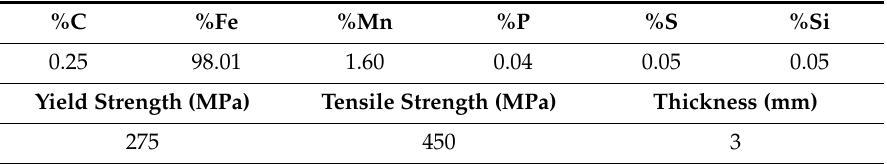
Table 1. Chemical composition and mechanical properties of s275 steel.